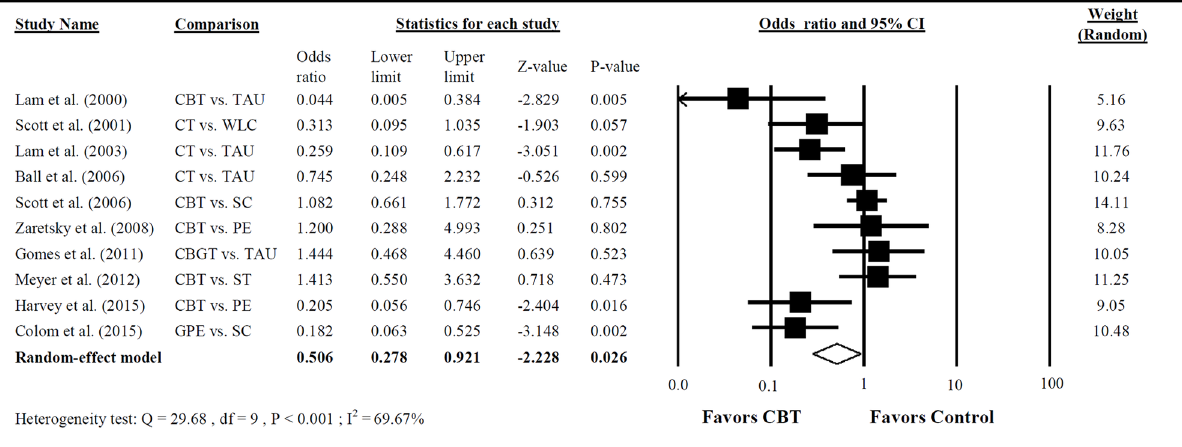
Fig 4. Forest plot of the meta-analysis for lowering the relapse rate of BD among patients treated with CBT compared with controls (n = 10 studies).